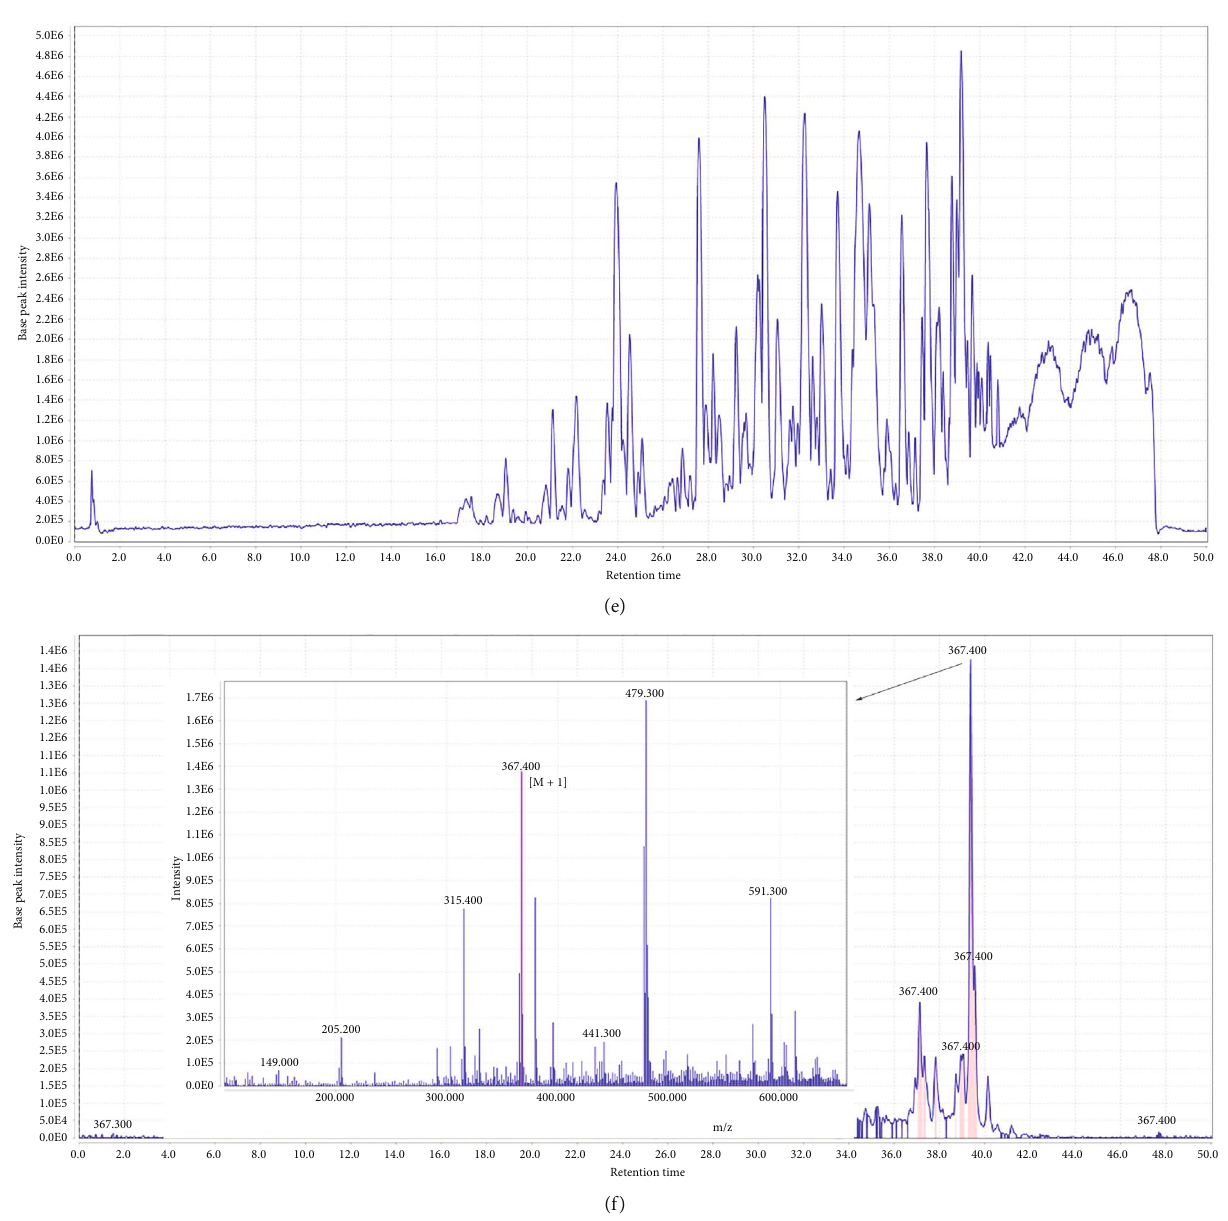
Figure 5: (a) The total ion chromatogram of Ferula assafoetida extract. (b) Chromatogram of umbelliprenin and corresponding mass adduct, ½ M + 1 (cid:2) , at m/z 367.4. (c) Chromatogram of foetisul fi de C and corresponding mass adduct, ½ M + 1 (cid:2) , at m/z 241.1. (d) Chromatogram of fetidone B and corresponding mass adduct, ½ M + 1 (cid:2) , at m/z 235.1. (e) Chromatogram of asadisul fi de and corresponding mass adduct, ½ M + 1 (cid:2) , at m/z 277.3. (f) Chromatogram of methyl-1-propenyl disul fi de and corresponding mass adduct, ½ M + 1 (cid:2) , at m/z